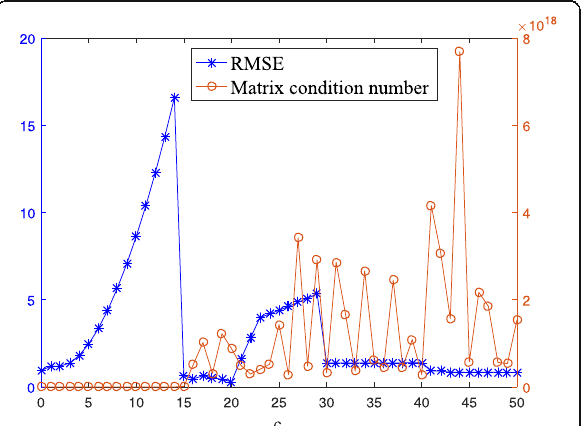
Fig. 11 Change curve of matrix condition number and